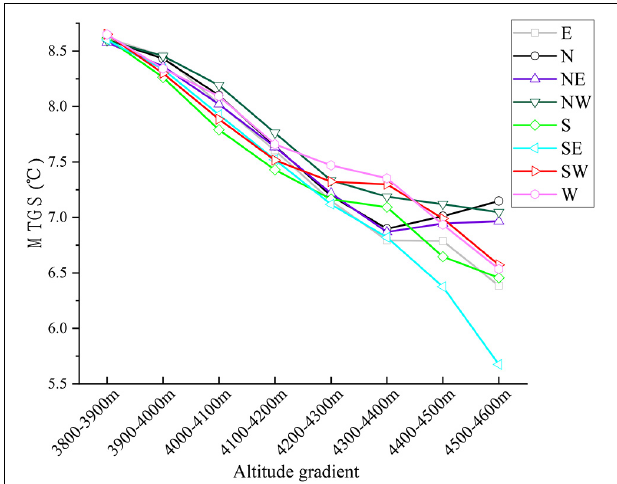
FIGURE 9 | The variation of mean temperature in growing season along the elevation gradient of treeline in different slope